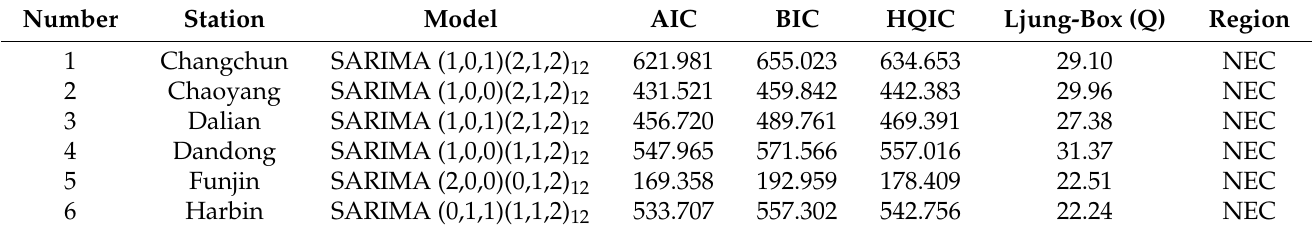
Table A2. The final SARIMA(p,d,q)(P,D,Q)s model parameters and test statistics for SPEI-12 time series of 160 meteorological stations over